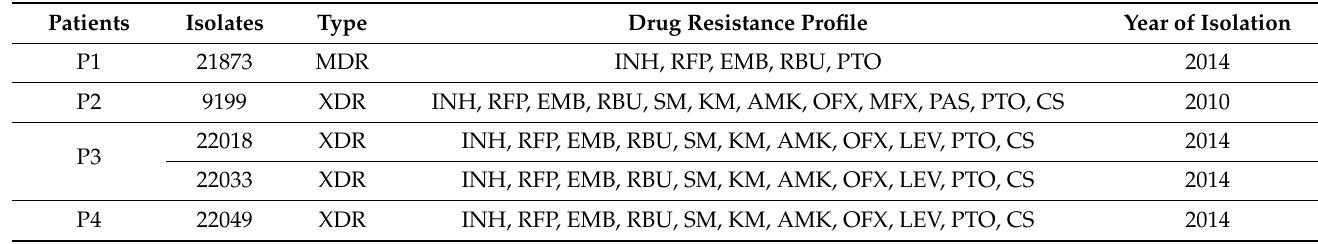
Table 1. Drug resistance data of clinical Mtb isolates.